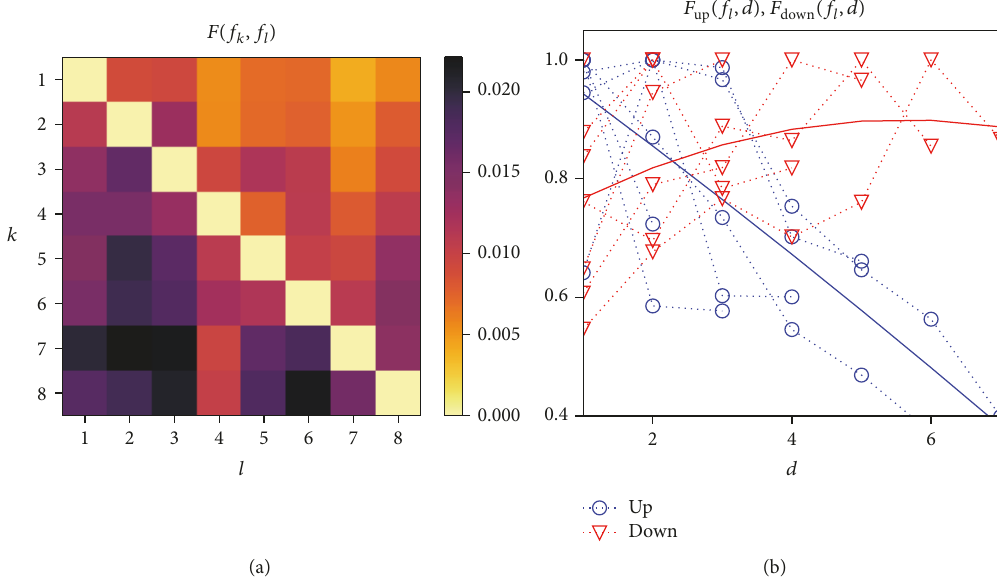
Figure 4: Average transfer entropy. (a) Average transfer entropy 𝐹(𝑓 𝑘 ,𝑓 𝑙 ) across values of 𝜏 between energy levels at different frequencies. (b) Tendencies of upward ( 𝐹 up (𝑓 𝑙 , 𝑑) , blue circle markers) and downward ( 𝐹 down (𝑓 𝑙 ,𝑑) , red triangular markers) transfer entropy values with respect to the distance 𝑑 between frequencies. Solid lines represent a least squares second-order polynomial fit (higher orders show a similar trend) of the values of 𝐹 up (𝑓 𝑙 , 𝑑) (blue solid line) and 𝐹 down (𝑓 𝑘 ,𝑑) (red solid line) with respect to 𝑑 . We observe how upward transfer entropy values display an important decrease with distance, whereas downward transfer entropy presents slightly larger values for larger